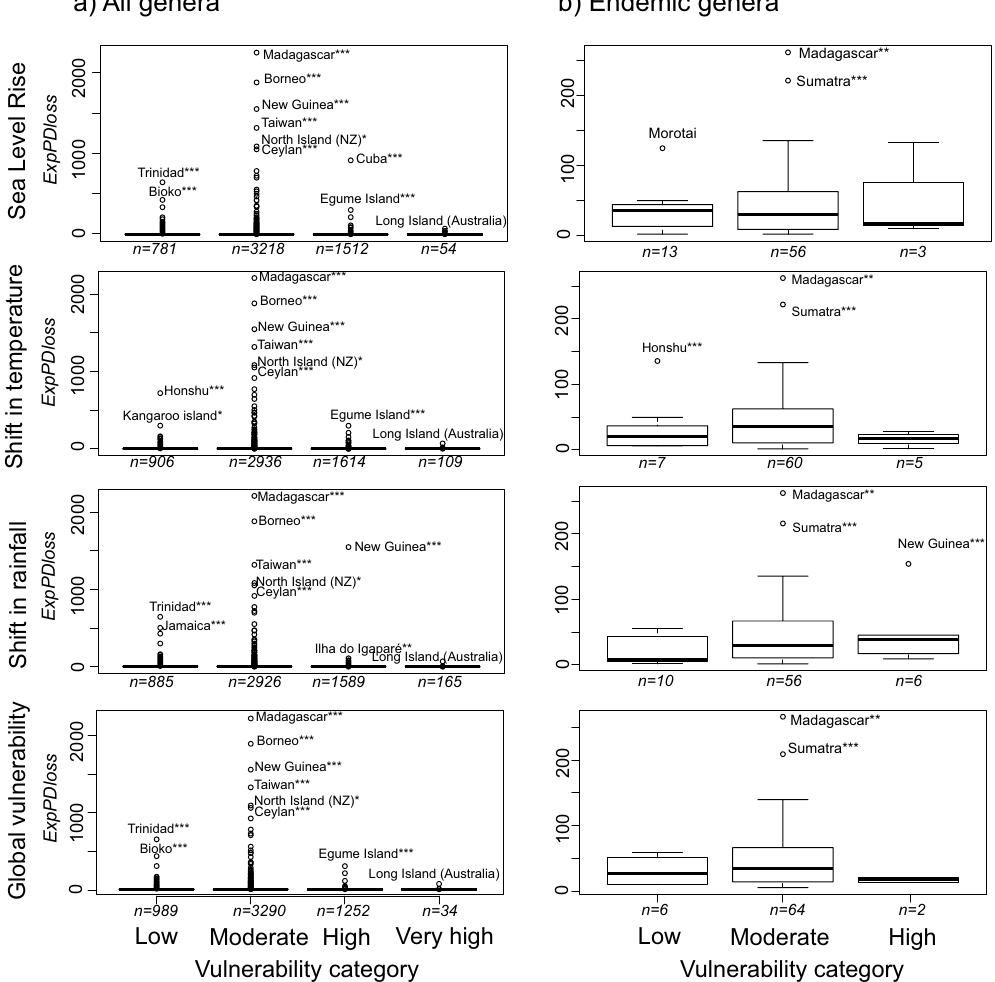
Figure 4. Expected loss of phylogenetic diversity for each vulnerability category and type of